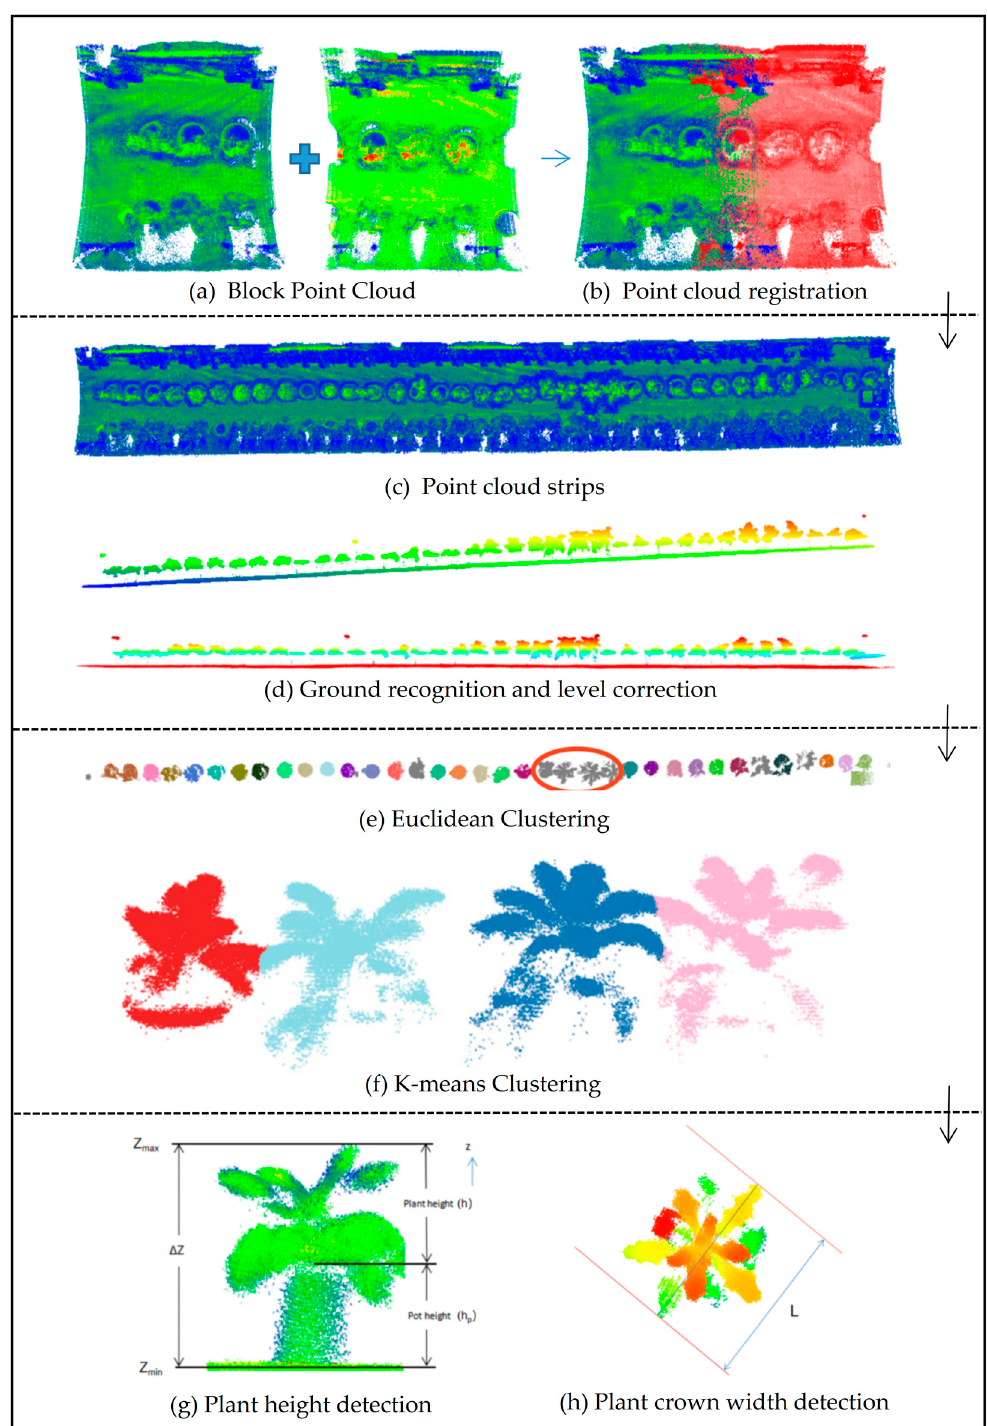
Figure 7. Point cloud processing